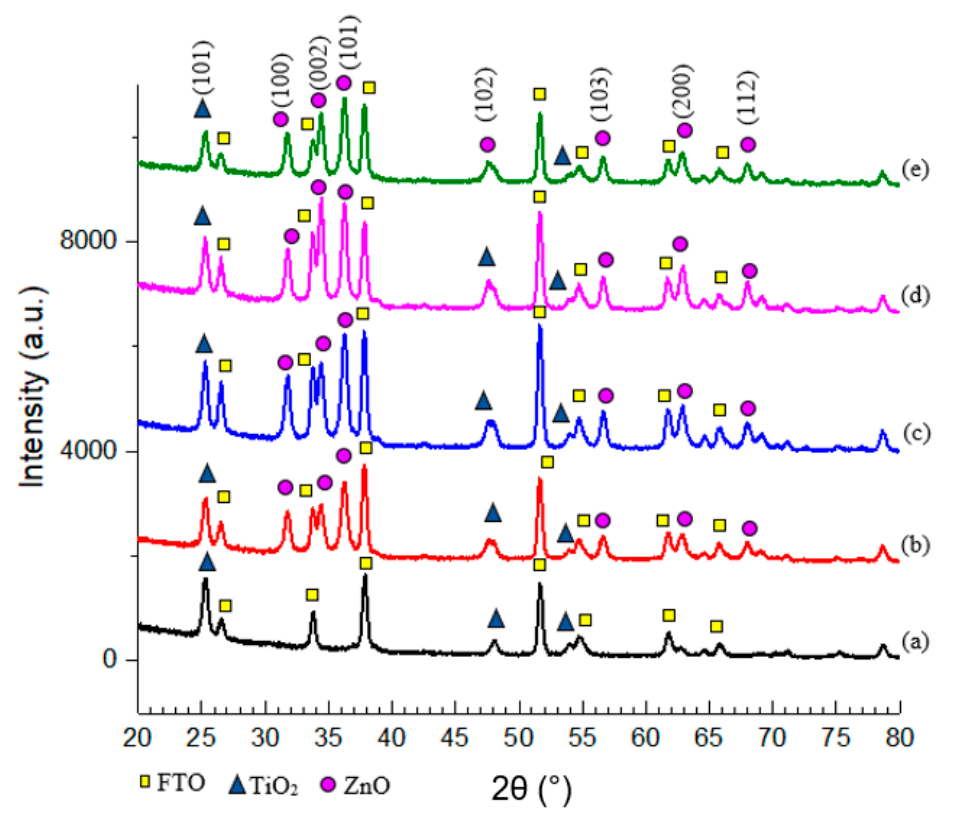
Figure 1. The XRD pattern for ( a ) n-TiO 2 /FTO substrate annealed at 600 ◦ C for 1 h; n-TiO 2 /ZnO bilayer thin film annealed at 500 ◦ C for ( b ) 1, ( c ) 1.5, ( d ) 2, and ( e ) 2.5 h, respectively.